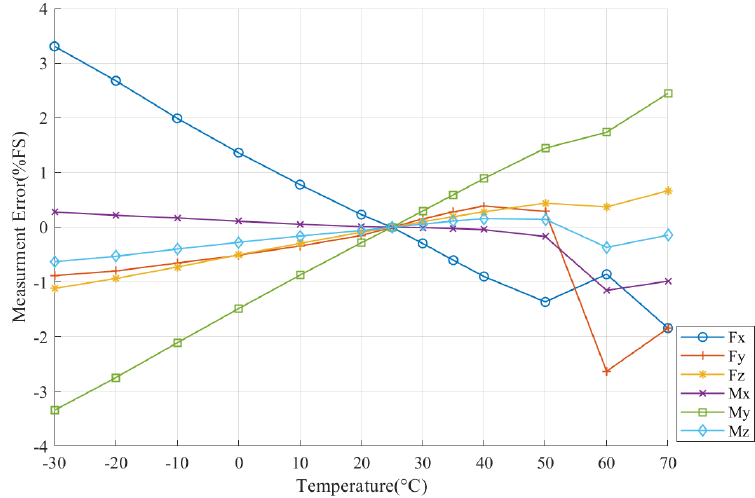
Figure 3. Measurement error before compensating by EhW-LSSVM.